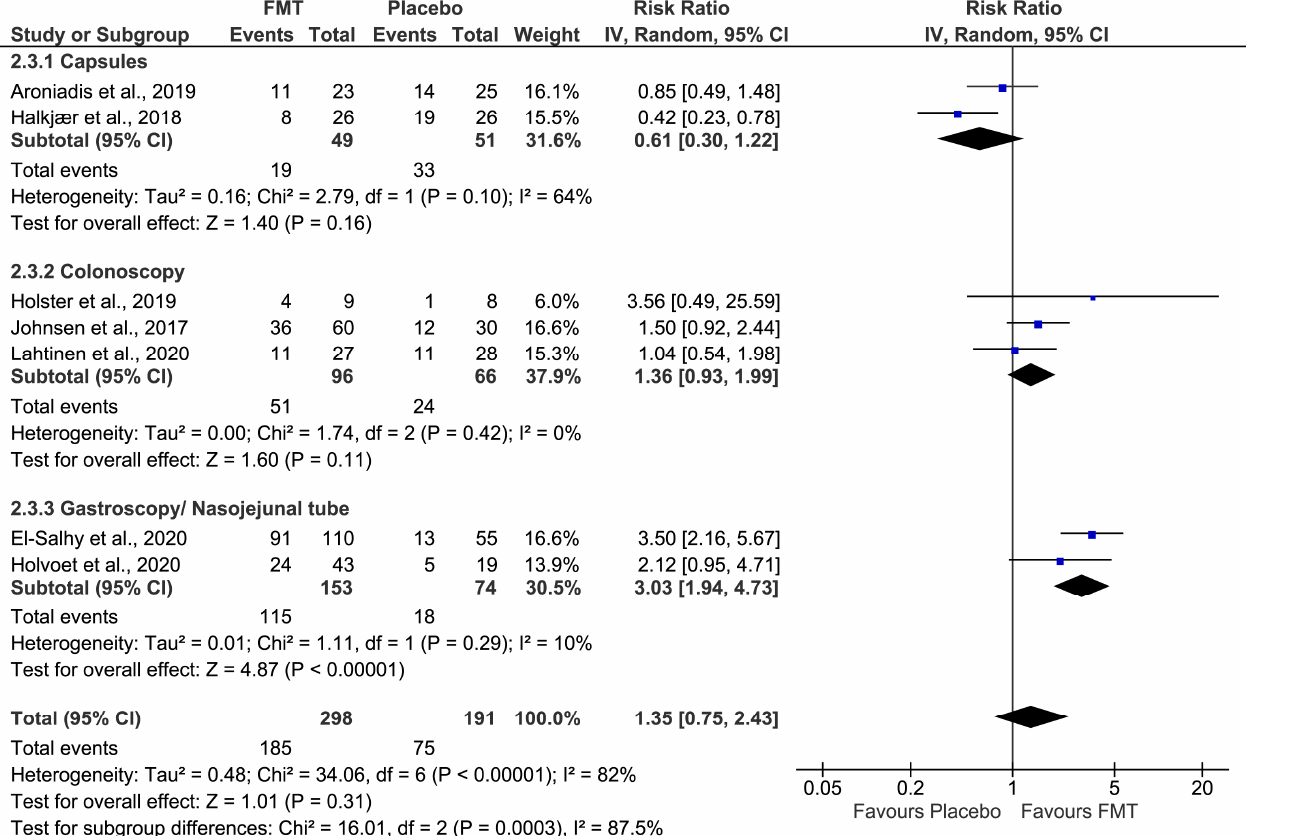
Table 5. Subgroup analyses of comparisons of FMT vs placebo in IBS between studies that delivered FMT through colonoscopy, gastroscopy and nasojejunal tube.